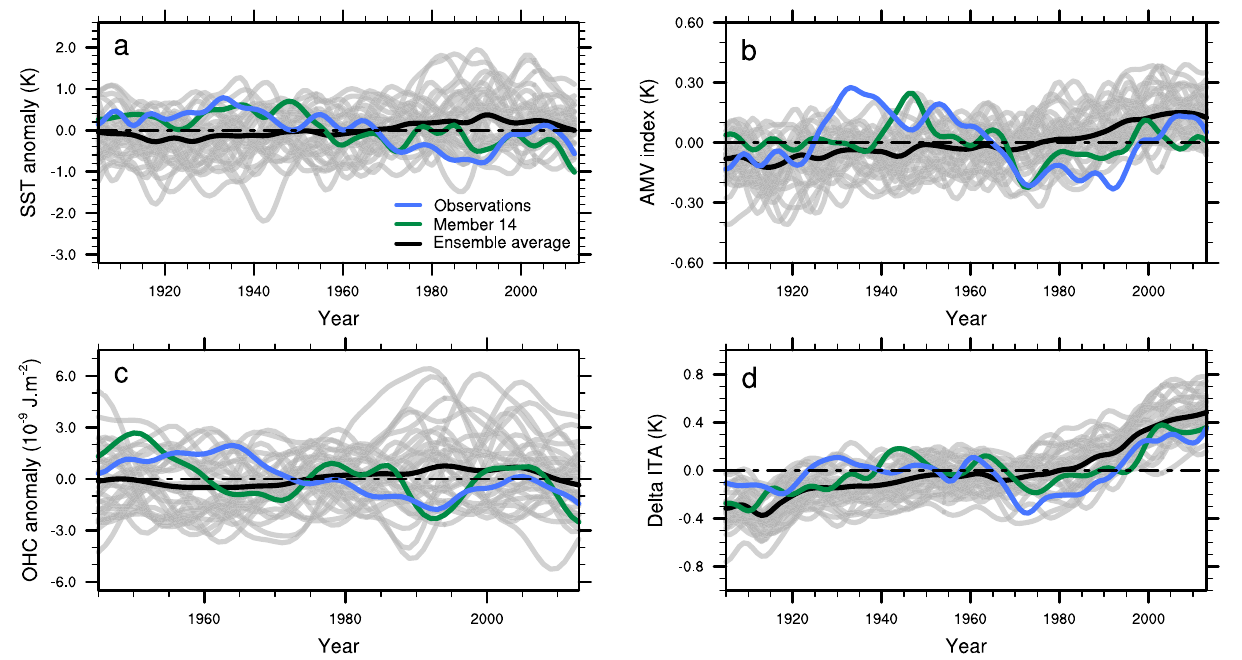
Fig. 3 Evaluation of Atlantic Meridional Overturning Circulation fi ngerprints. a Time evolution of the Caesar index computed as the low-pass fi ltered sea surface temperature anomaly (K) averaged over the North Atlantic Subpolar Gyre from November to May from the ERSSTv5 observational dataset 54 (blue), the 32 historical members (gray) with the ensemble mean (black) and member #14 (green). b , Same as a but for the Atlantic Multidecadal Variability index (see Methods). c Same as a but for the Ocean Heat Content (OHC) anomaly (10 9 J m − 2 ) between 0 and 700 m averaged over the Newfoundland region minus the OHC averaged over the North Atlantic Subpolar Gyre region from the IAP observational dataset 55,56 (blue) d Same as a but for the interhemispheric near-surface air temperature difference (K), with the HadCRUT4-CW observational dataset 41,42 (blue). A Lanczos low-pass fi lter with a cutoff period of 11 years is used in c and d and the anomalies are computed over the displayed